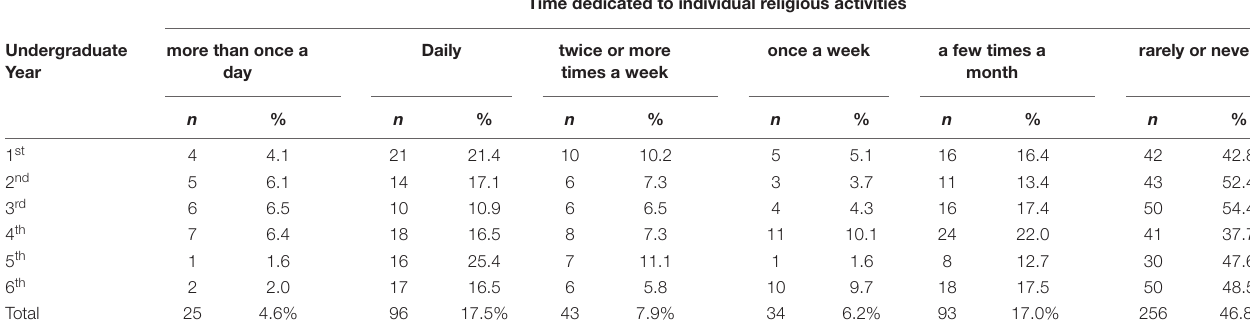
TABLE 5 | Time dedicated to individual religious activities by students from different religious affiliations.